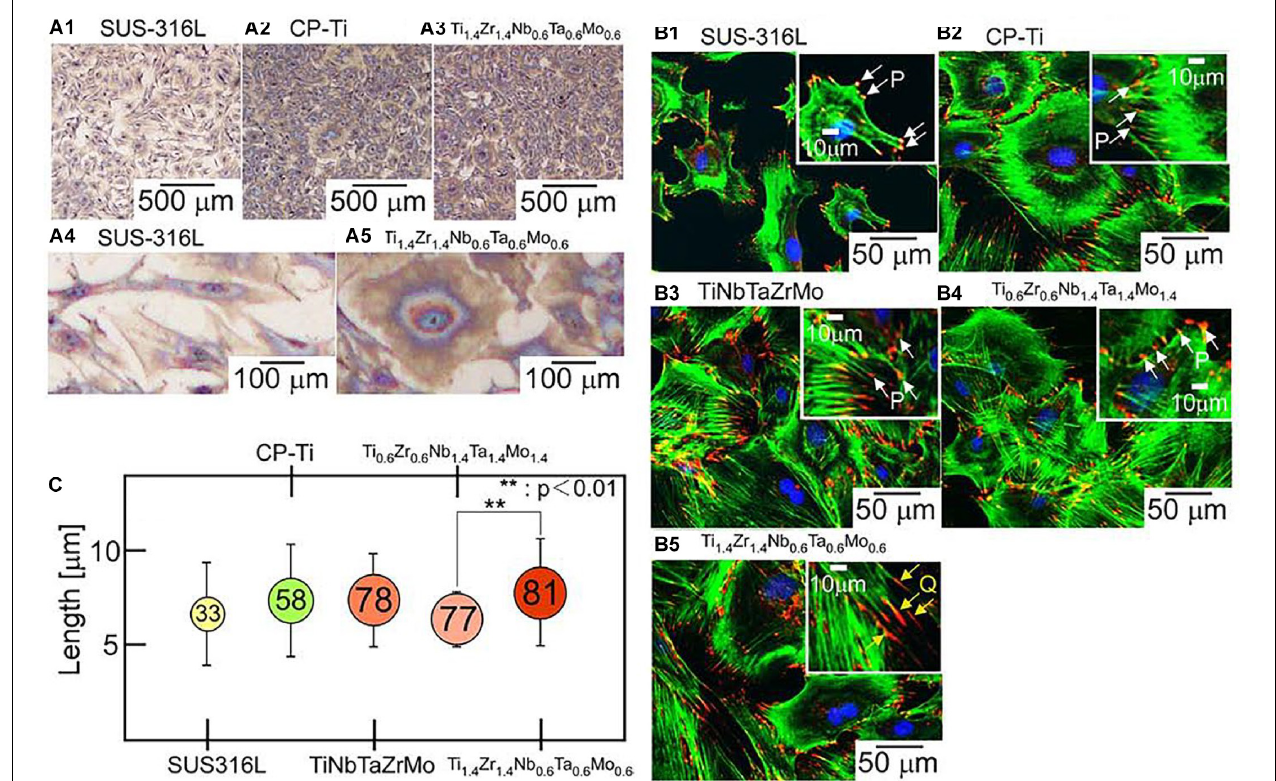
FIGURE 10 | Biocompatibility of the ingots of bio-HEAs. (A) Giemsa staining images of osteoblasts on the fabricated specimens of SUS316L (stainless steel), CP-Ti (commercial pure titanium), and Ti 1 . 4 Zr 1 . 4 Nb 0 . 6 Ta 0 . 6 Mo 0 . 6 , (B) fluorescent images of osteoblast adhesion on the fabricated specimens of SUS316, CP-Ti, equiatomic TiNbTaZrMo, and non-equiatomic Ti 2 − x Zr 2 − x Nb x Ta x Mo x ( x = 0.6, 1.4) bio-HEAs, and (C) quantitative analysis of size regulation of fibrillar adhesions (longer than 5 µ m) in osteoblasts cultured on the fabricated specimens (Hori et al., 2019). Reproduced from Hori et al. (2019) with